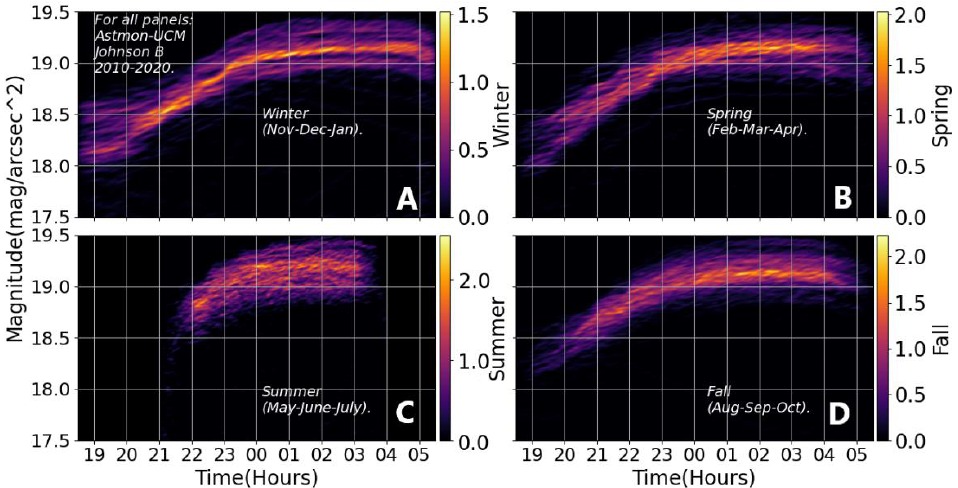
Figure 16. Seasonal variation of sky brightness throughout the night in the Johnson B photometric band. The winter here is defined from November to January. Panels ( A – D ) are for the Winter, Spring (February to April), Summer (May to July), and Fall (August to October) from 2010 to 2020.